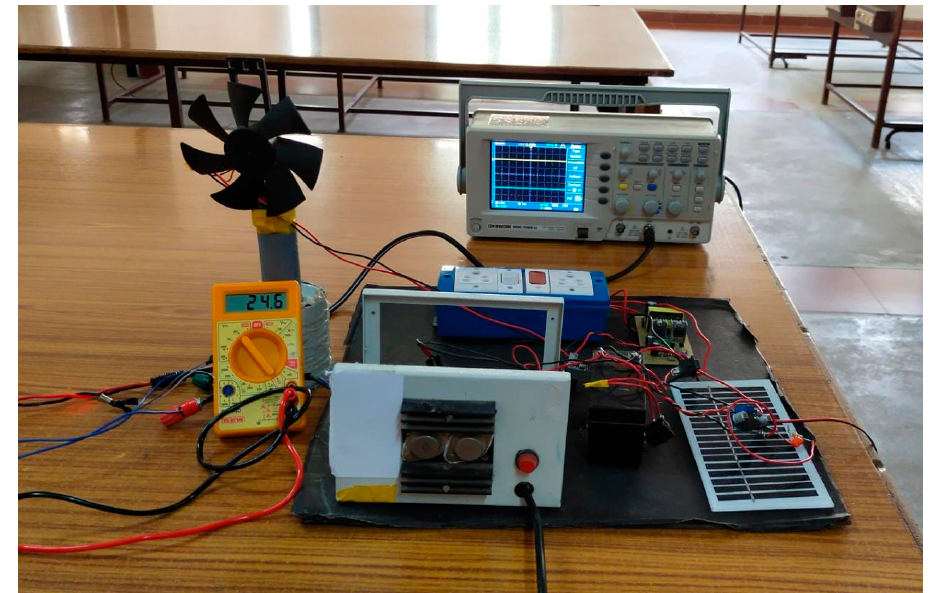
Figure 10. Simulation response of output voltages.